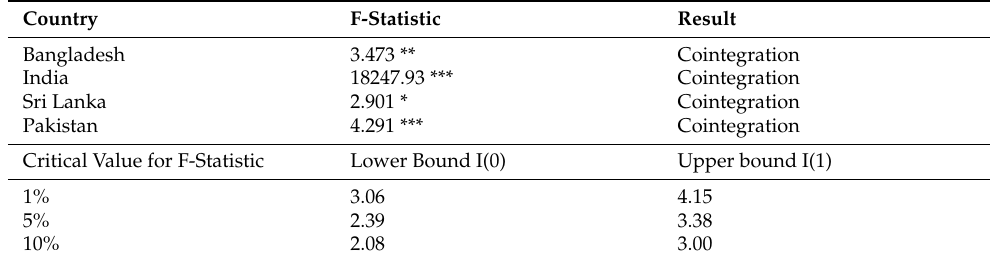
Table 4. Results of the NARDL test for cointegration. Model: LnCo2 = f(LnE, LnY, Ln Y 2 , Ln T + , Ln T − ).